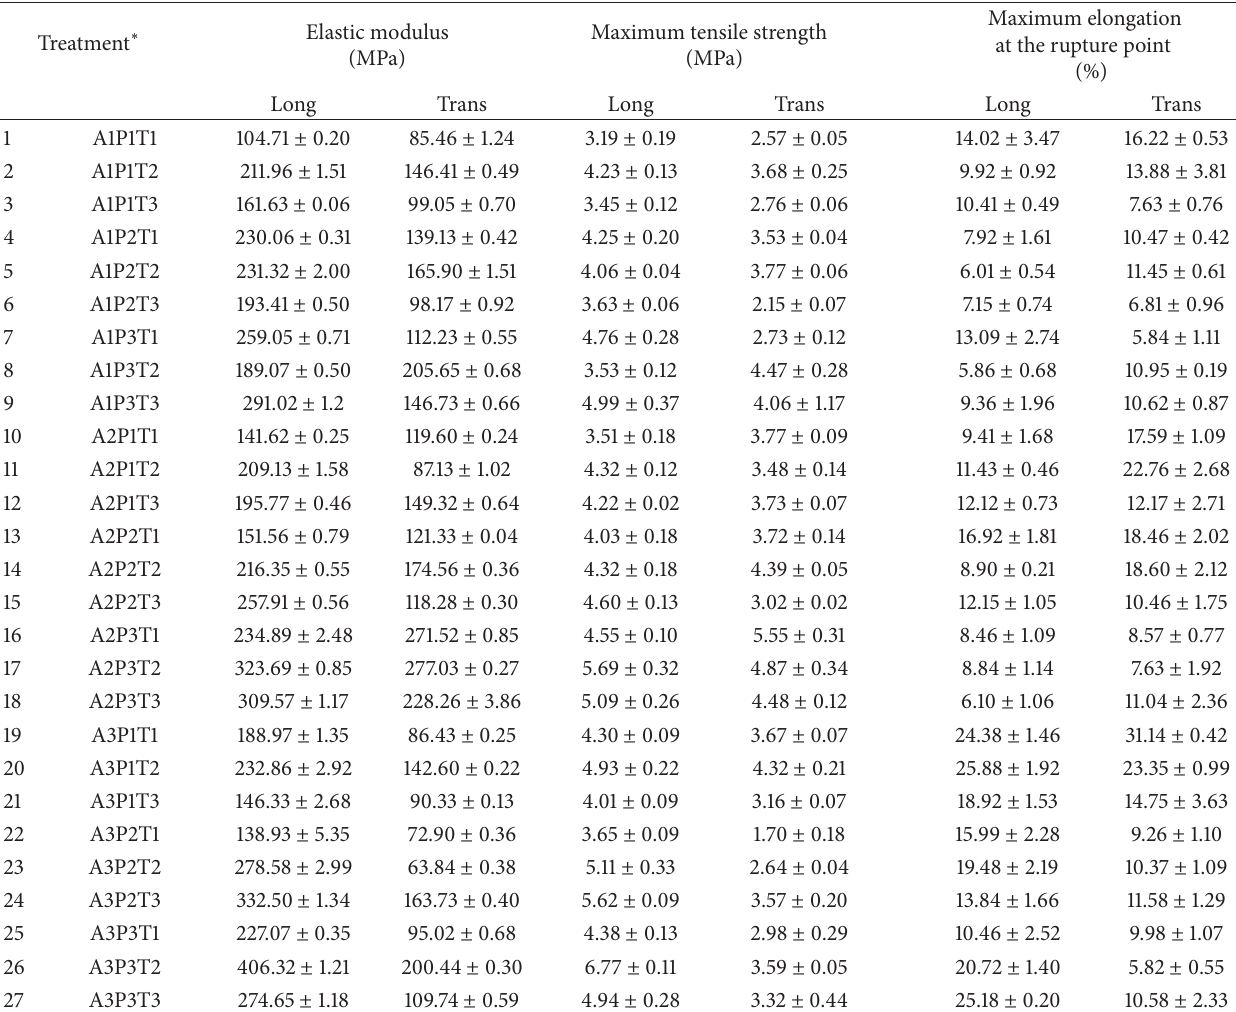
Table 1: Results of tensile mechanical